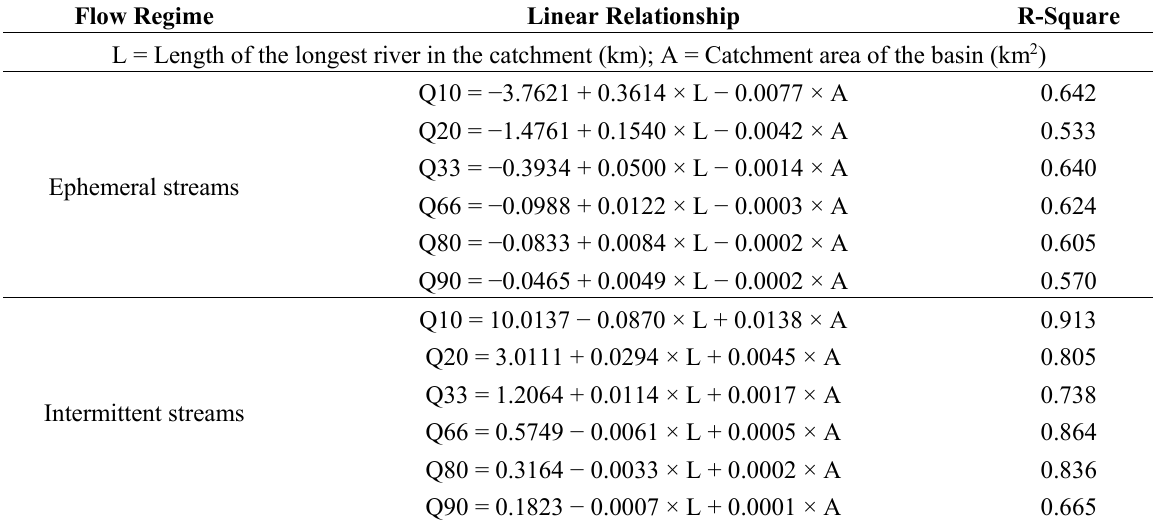
Table 4. Linear relationship of catchment descriptors with flow duration curve for each flow